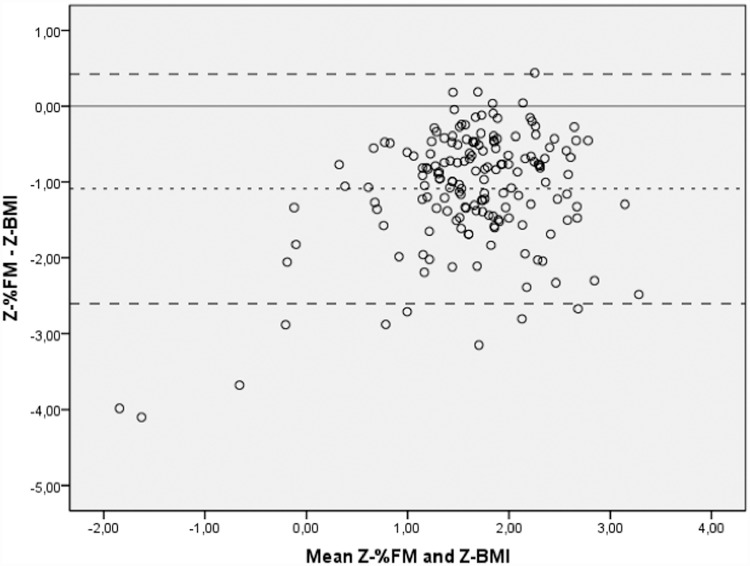
Bland-Altman analysis between the Z-BMI scores and the Z-%FM scores.The difference between the Z-scores from BMI and those of the Z-%FM was -1.088 (95% CI: -2.602 to 0.426), and there was only 1 case (0.6%) above the upper threshold the agreement interval, and 9 (5.3%) below the lower threshold.